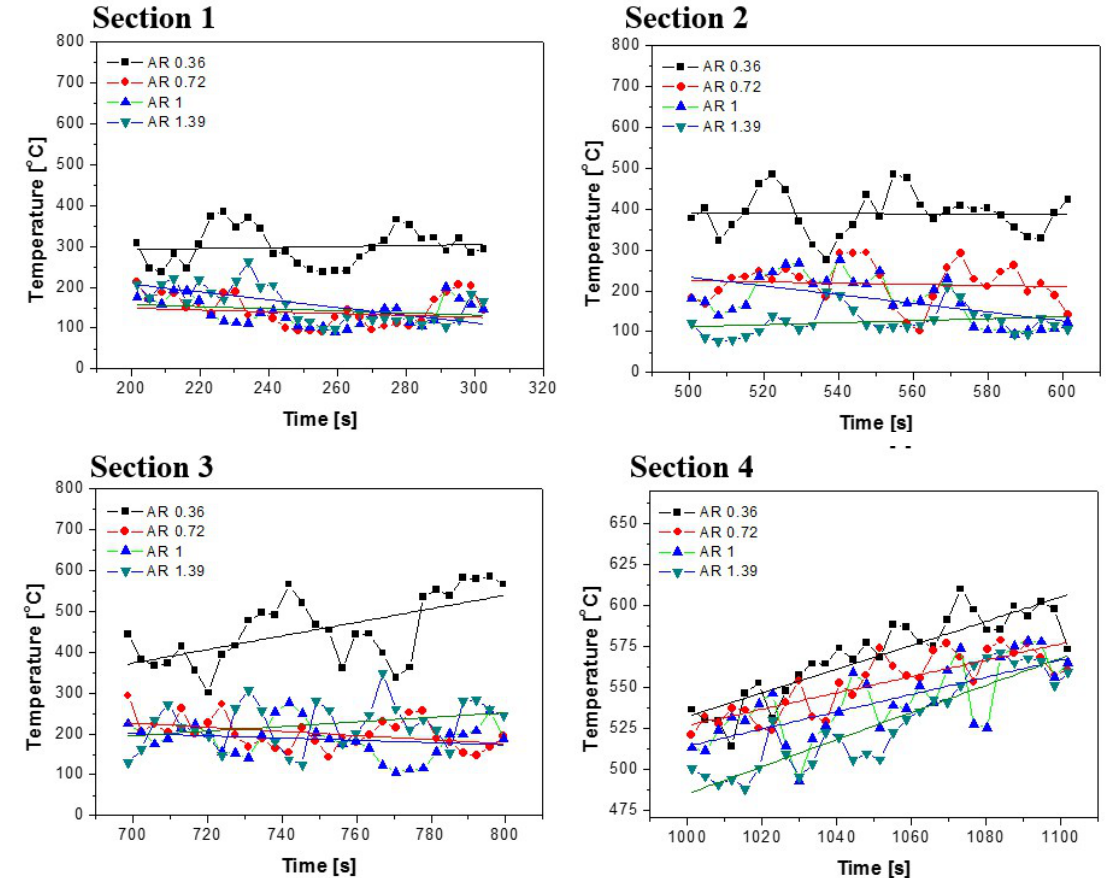
Figure 13. Temperature distribution at the specific times for the various aspect ratio at the point of where below 0.2 m of ceiling, ( Section 1 ) represents the temperature values from 200 s to 300 s, ( Section 2 ) represents the temperature values from 500 s to 600 s, ( Section 3 ) represents the temperature values from 700 s to 800 s and ( Section 4 ) represents the temperature values from 1000 s to 1100 s to compared to other sections.